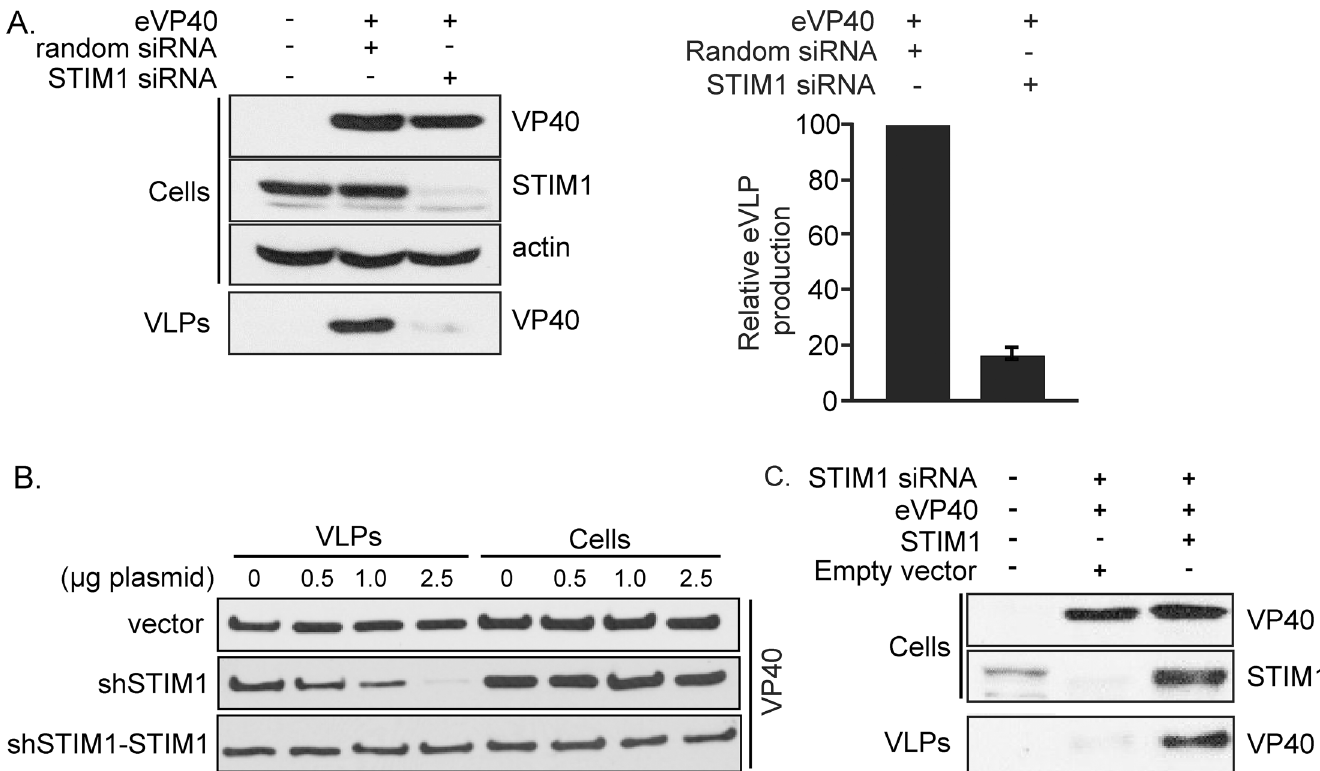
Fig 3. STIM1 suppression inhibits egress of eVP40 VLPs. A . VP40 was expressed in control and STIM1 suppressed HEK293T cells as indicated and eVP40 VLP production quantified by immunoblot analysis demonstrates significant inhibition of eVP40 production in STIM1 suppressed cells (n = 4 independent experiments). B . Immunoblot analysis of cell extracts and VLPs from HEK293T cells expressing eVP40 in cells co-transfected with indicated amounts of control vector (top panel), STIM1 suppression plasmid (middle panel), or shSTIM1-STIM1 suppression-rescue plasmid (bottom panel). C . Cellular VP40 and STIM1 levels were measured in mock-transfected HEK293T cells, or cells transfected with the indicated plasmids and siRNAs. Results are representative of three independent experiments.